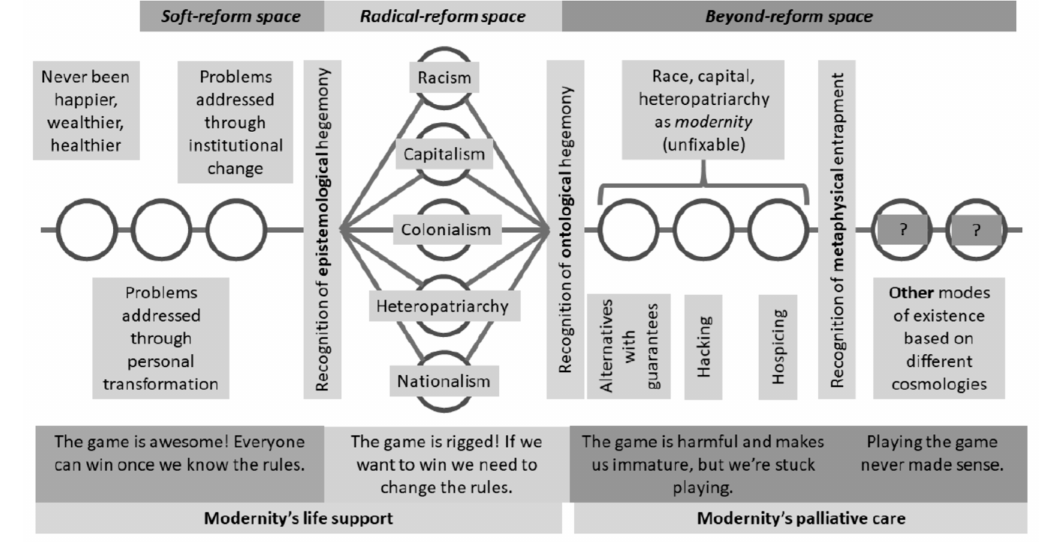
Figure 1. Cartography 3: different approaches to reform with regard to modernity/coloniality (Source: Stein et al., 2020: